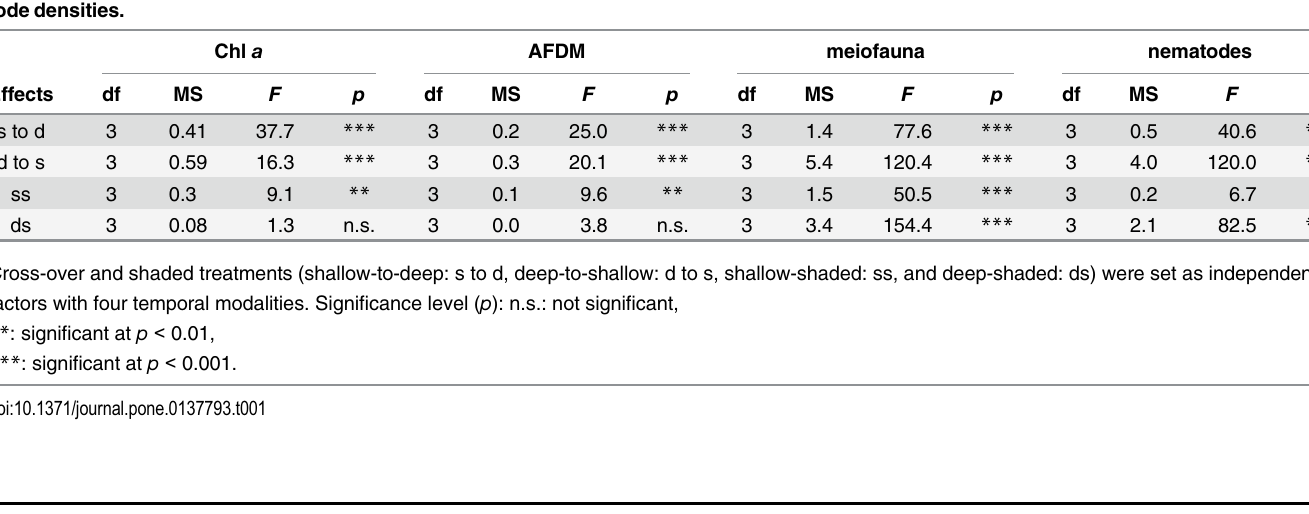
Table 1. Summary of rmANOVA of temporal differences in the amounts of periphytic chlorophyll a (Chl a ) and AFDM and in meiofaunal and nema- tode densities. Chl a